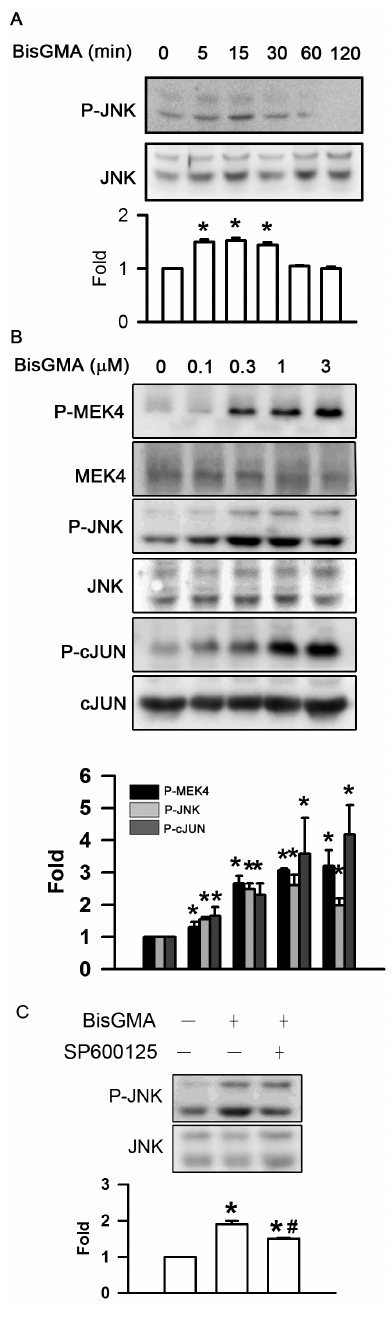
Figure 7. Effects of BisGMA on the phosphorylation of JNK pathway. (A) RAW264.7 macrophages were stimulated with 3 m M BisGMA for the indicated treatment periods. Cells were harvested and protein extracts were subjected to SDS-PAGE. Western blot analysis using antibodies against phosphorylated and total JNK. (B) Cells were stimulated with the indicated concentrations of BisGMA for 15 min. (C) After treatment with 30 m M SP600125 for 30 min, cells were stimulated with 3 m M BisGMA for 15 min. Cells were harvested and protein extracts were subjected to SDS-PAGE Western blot analysis using antibodies against phosphorylated and total MEK4, JNK, and cJUN. The ratio of immunointensity between the phosphorylation and total protein was calculated. Values are expressed as mean 6 SD (n=3). *represents significant difference from control values with p , 0.05. # represents significant difference from BisGMA values with p ,